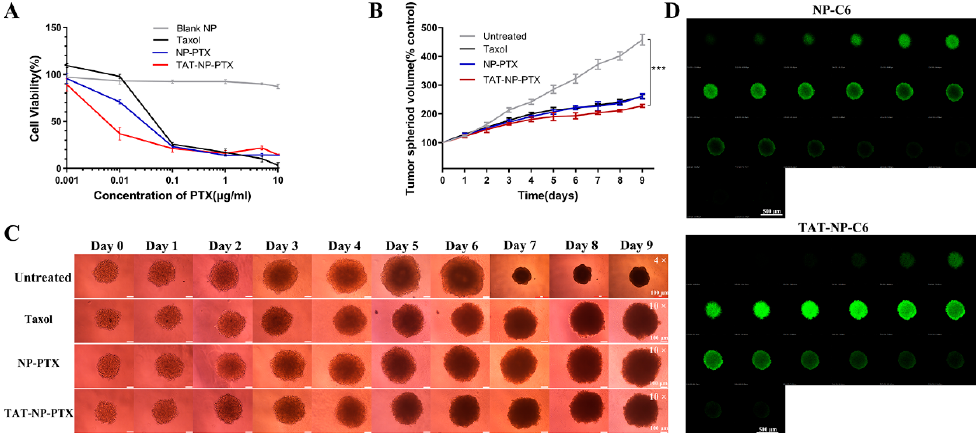
Figure 2. ( A ) Cell viability of MCF-7 cells after incubated with Paclitaxel (PTX) formulation for 72 h. ( B ) Quantification of tumor spheroid volume in each group based on images. Data were expressed